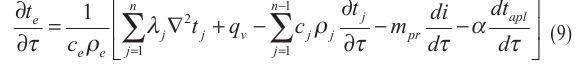
vir(cid:154)iaus temperat ū r ą lemia daugelis tarpusavyje temperat ū ros apskai č iavimas yra galimas, ta č iau komplikuotas d ė l to, kad nei(cid:154)spr ę sta (cid:158)mogaus fiziologini ų veiksni ų tarpusavio ry(cid:154)i ų problema ir tr ū ksta (cid:158)ini ų apie atskiras (cid:158)mogaus k ū no audini ų fizikini ų dyd(cid:158)i ų konstantas. Lokalios temperat ū - ros poky č iai, (cid:158)mogui pereinant i(cid:154) ramyb ė s į darbi- n ę b ū sen ą ir atliekant tam tikro sunkumo darb ą , gali b ū ti tiriami eksperimenti(cid:154)kai. Odos temperat ū ros kitimo vir(cid:154) dirban č io raumens eksperimentiniai duomenys. Odos temperat ū ros kitimas vir(cid:154) dirban č io raumens, kil- nojant 2 kg svor į 4 minutes tuo pa č iu 40 min -1 da(cid:158)numu į 0,5 m auk(cid:154)t į , pateiktas 3 paveiksle. Akivaizd ū s odos temperat ū ros poky č iai po 1 mi- nut ė s darbo. Pastebimas skirtingas temperat ū ros kitimo pob ū dis vir(cid:154) dirban č io raumens. Vidin ė je raumens pus ė je visais steb ė tais atvejais antr ą minut ę nuo kr ū vio prad(cid:158)ios pastebimas nedidelis (iki 0,16 o C) temperat ū ros suma(cid:158) ė jimas, po kurio seka stai- gesnis temperat ū ros augimas. Temperat ū ra, esant min ė tai apkrovai, pakyla (0,9(cid:151)1,6 o C) ir pasiekia s ą lygi(cid:154)kai stabili ą (cid:154)ilumos main ų b ū sen ą po 4 darbo minu č i ų . Nutraukus darb ą , pastovi tempera- t ū ra s ą lygi(cid:154)kai laikosi dar 10 min. Analogi(cid:154)kas temperat ū ros kitimas pastebimas kilnojant 4 kg svor į 1 minut ę 40 min -1 da(cid:158)numu į 0,5 m auk(cid:154)t į (4 pav.). Lyginant duomenis, pateiktus 3 ir 4 paveiksle, matyti, kad raumeniui dirbant visi(cid:154)kai skirtingais kr ū viais, odos temperat ū ros kitimo d ė sningumas vir(cid:154) dirban č io raumens i(cid:154)lieka analogi(cid:154)kas.